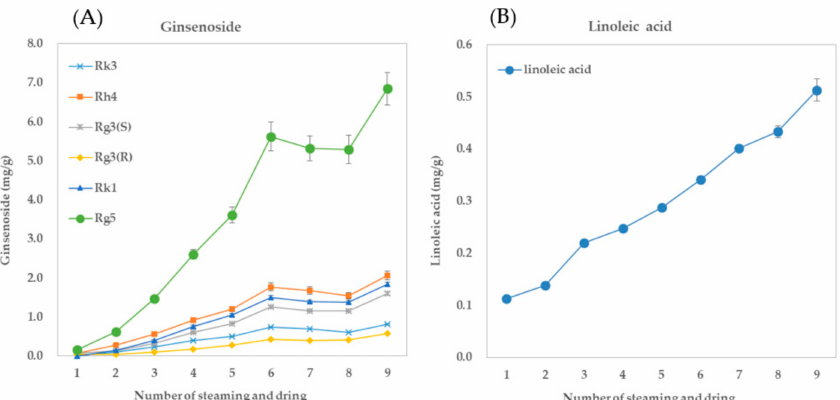
Figure 4. The profiles of ginsenosides (Rk1, Rg3 ( S / R ), Rh4, Rk3 and Rg5) ( A ) and linoleic acid ( B ) during the manufacturing process of black ginseng. The results show that linoleic acid contents appeared to more accurately reflect hydrothermal history than ginsenosides in the manufacturing of black ginseng products. Table 3. Amounts of ginsenosides in fresh ginseng main root extracts after treatment by ninth repetitive steaming and drying. Number of Steaming and Dring